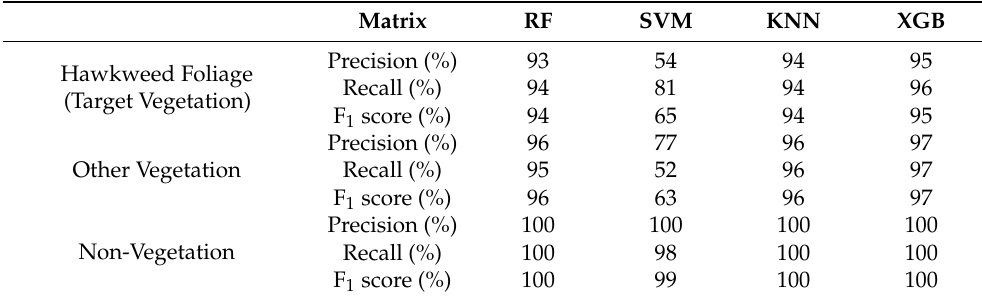
Table 13. Classification report (validation) of different machine learning models for detection of hawkweed foliage at 0.65